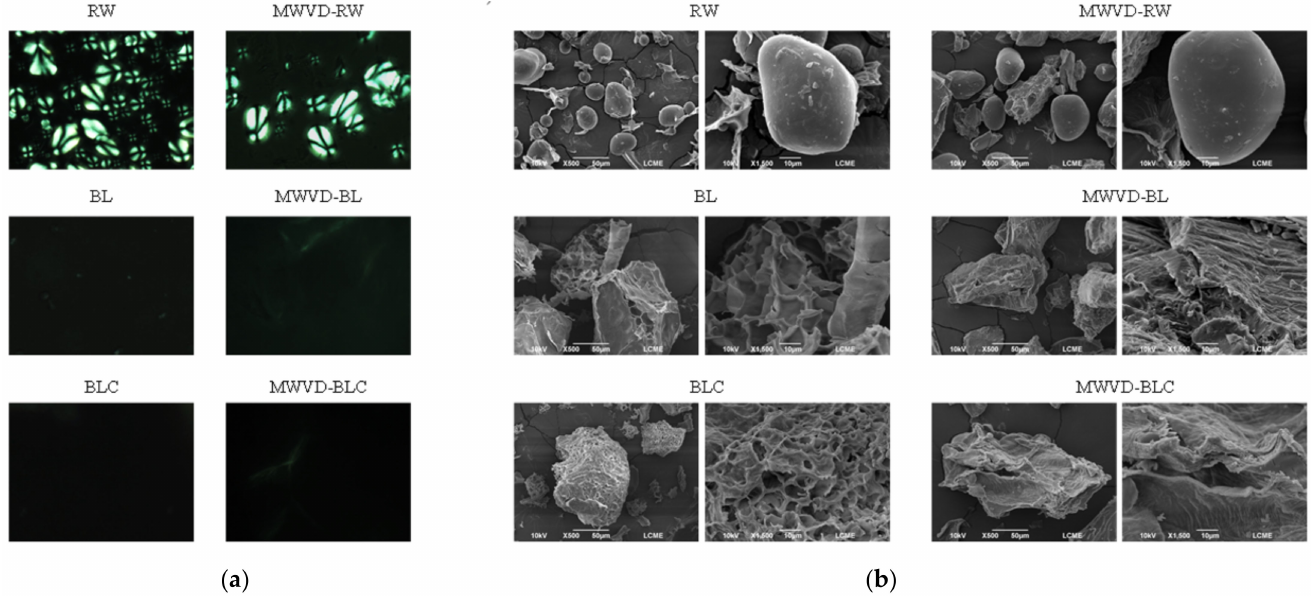
Figure 4. Micrographs obtained by polarized light microscopy ( a ) and MEV-500 × and 1500 × magni- fication ( b ) of fresh (RW, BL, and BLC) and dried (MWVD-RW, MWVD-BL, and MWVD-BLC) potato